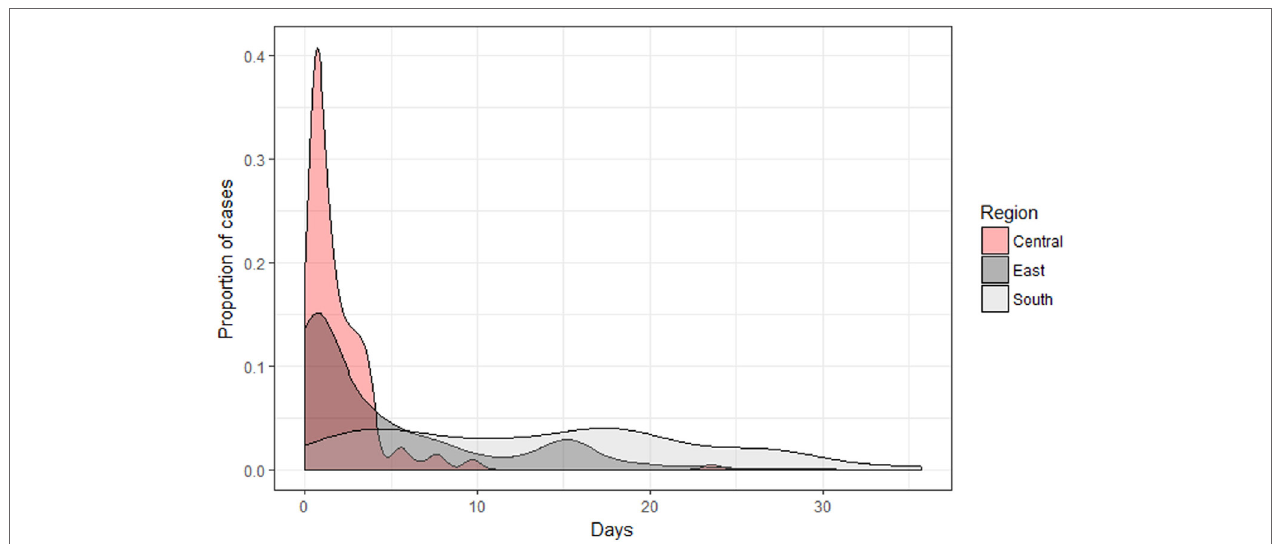
FigUre 2 | Density plot illustrating a comparison by region of the number of days required for a case to be available on the Cloud-based server when using the VetAfrica smartphone